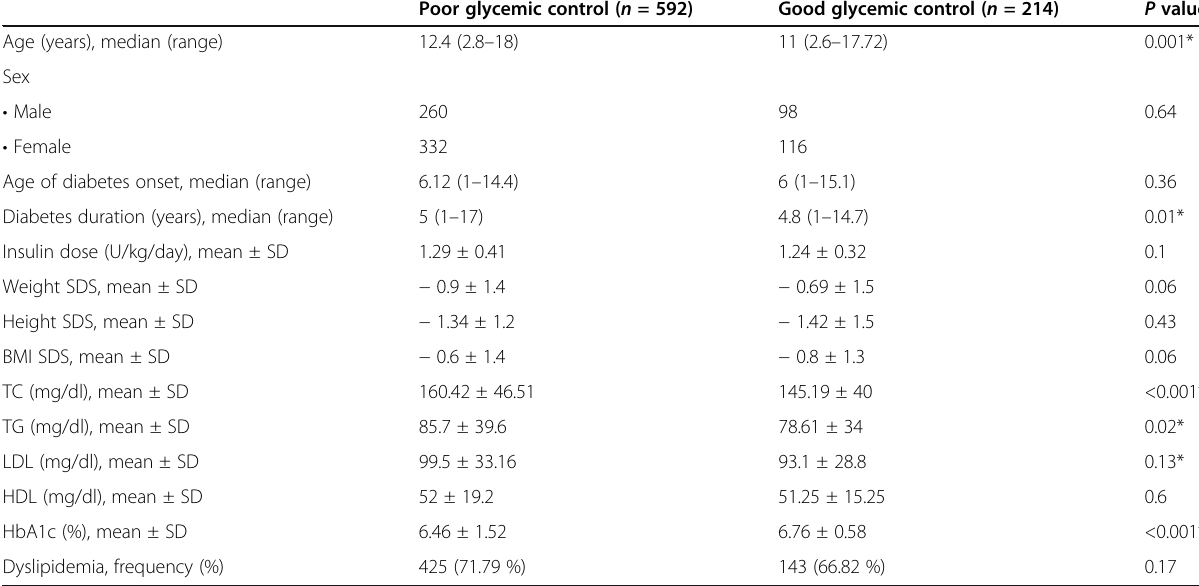
Table 3 Demographic and laboratory characteristics of the study group by glycemic control Poor glycemic control ( n = 592) Good glycemic control ( n = 214)